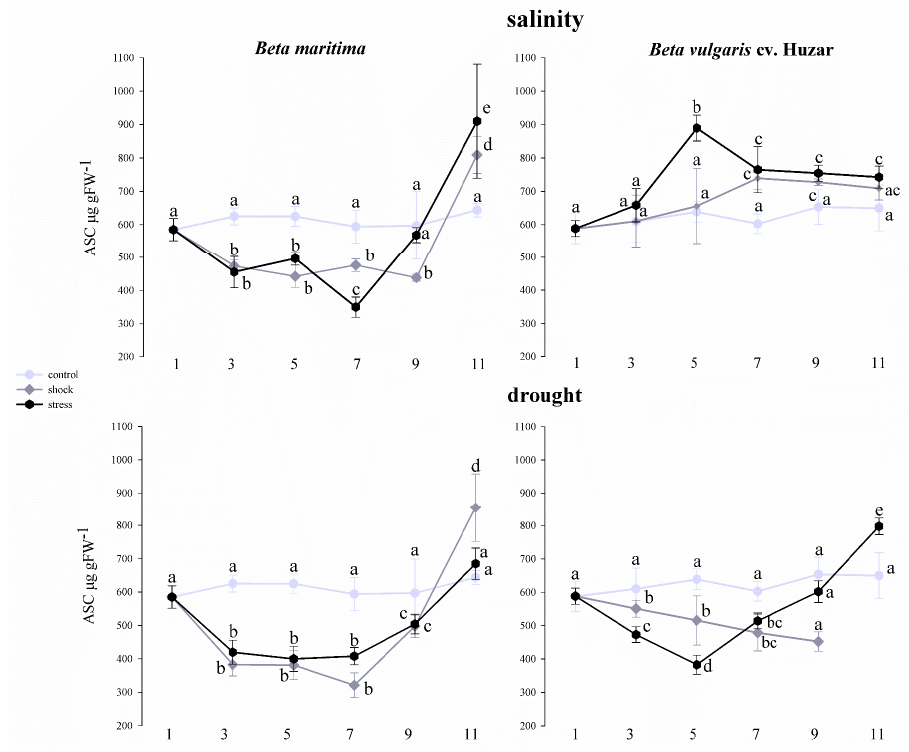
Figure 9. Total ascorbate concentration determined in leaves of Beta vulgaris ssp. maritima and Beta vulgaris cv. Huzar subjected to salt shock or stress and drought shock or stress. Control − light gray bars, salt shock − gray bars, salt stress − black bars. Different letters denote significant differences at p < 0.01 (ANOVA followed by Tukey’s test). “whiskers” indicate standard deviation.